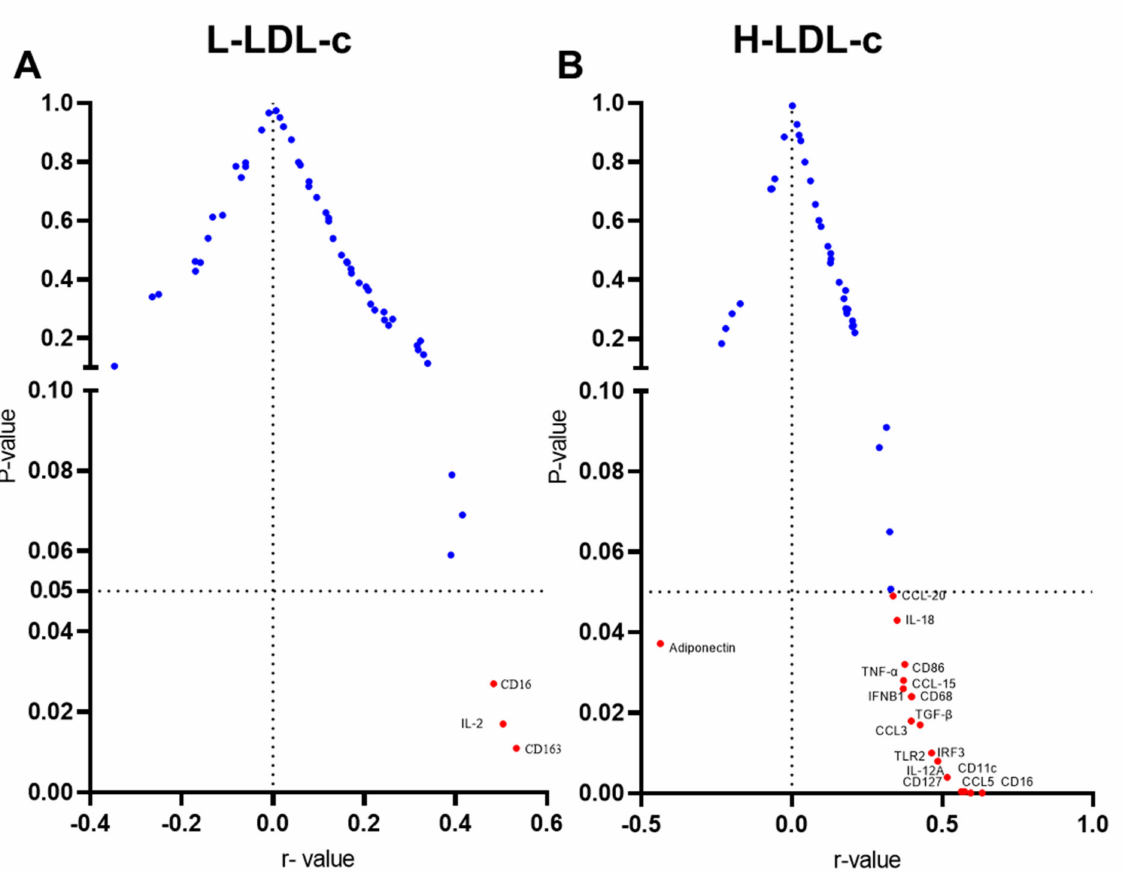
Figure 5. ( A ) Volcano plots represent correlation of IL-23 with differentially expressed genes in adipose tissue of people with L-LDL-c; red dots represent the significant correlation of IL-23 with other markers. ( B ) Volcano plots represent correlation of IL-23 with differentially expressed genes in adipose tissue of people with